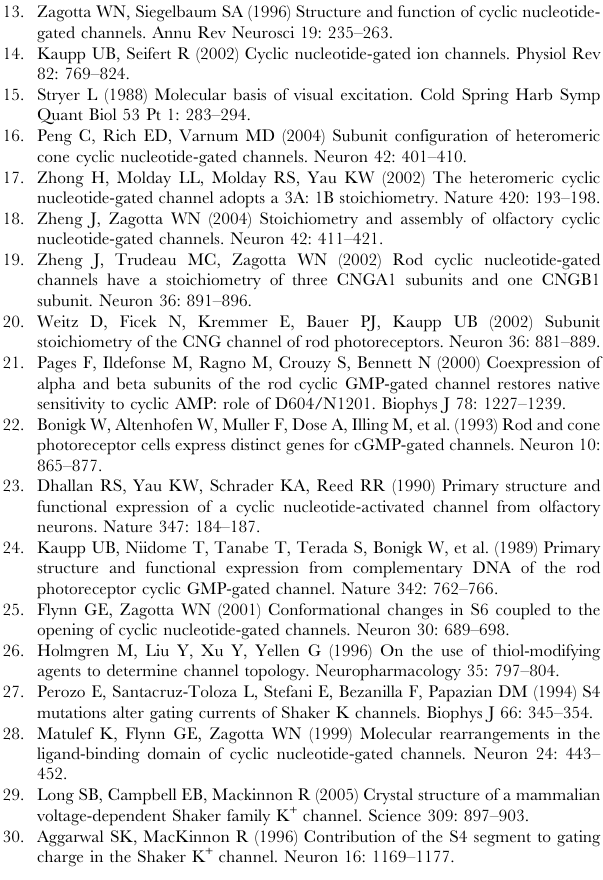
Figure S1 Cell surface expression time course of cysteine-less CNGA1-GFP channels exposed to MTSEA. A. Representative confocal images of one oocyte before (T0) and after 2 mM MTSEA exposure. Media with fresh MTSEA was